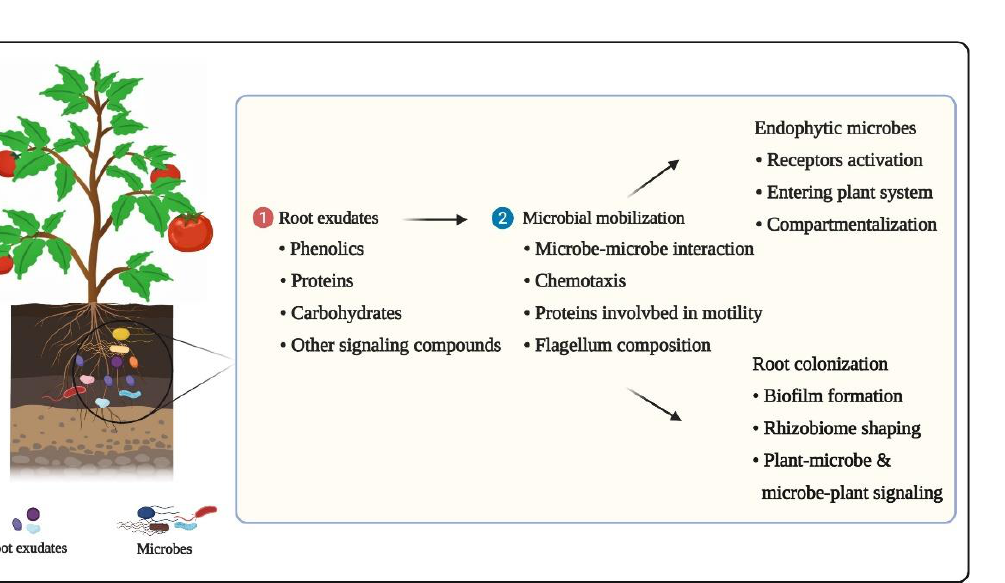
Figure 1. Various steps that occur during the assembly of the plant microbiome are depicted schematically. Firstly, plants release signaling molecules (i.e., phenolics, proteins, etc.) in the form of rhizodeposits to attract microbial community (step 1). Secondly, microbes respond to plant oriented signaling molecules by initiating mobilization and colonizing various plant parts as epiphytes and endophytes (step 2). The final diversity of the plant microbiome is shaped by a series of stages involving intricate signaling between plants and microorganisms.